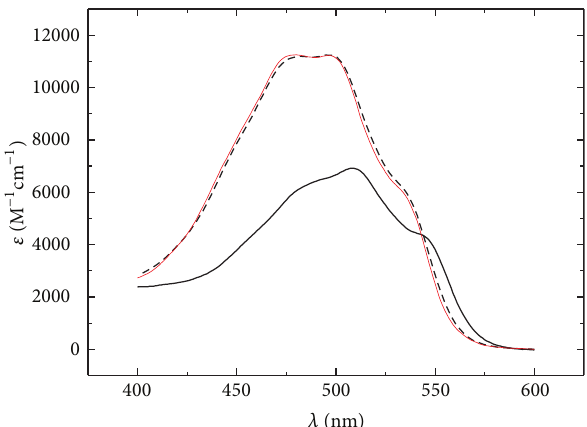
Figure 6: Free (dashed line) and bound (solid line) molar extinction coefficient spectra determined by the SVD fitting model for Daun compared with free DNA-Daun sample extinction coefficient spec- tra (soft solid line).